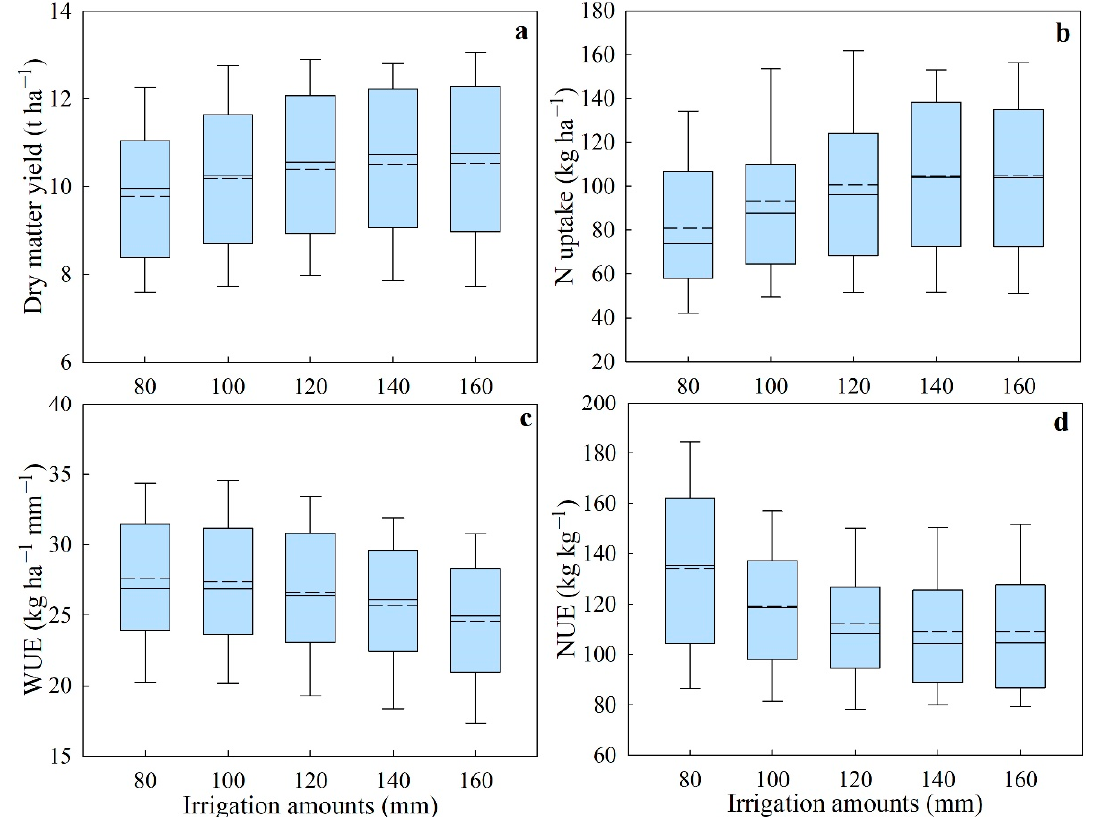
Figure 7. The 30-year average dry matter yield ( a ), N uptake ( b ), WUE ( c ), and NUE ( d ) of oat as affected by the amount of irrigation on the Tibetan Plateau. The bottom and top edges of the box show the 25th and 75th quantiles, the solid line is the data median, and the dotted line is the data average.